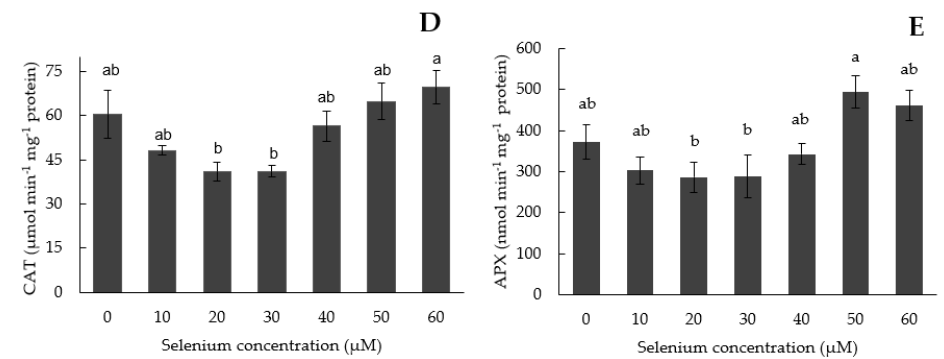
Figure 3. Effect of selenium concentration on lipid peroxidation (MDA) in rocket leaves ( A ). Effect of selenium concentration on the hydrogen peroxide content (H 2 O 2 ) in rocket leaves ( B ). Effect of selenium concentration on superoxide dismutase (SOD) in rocket leaves ( C ). Effect of selenium concentration on catalase (CAT) in rocket leaves ( D ). Effect of selenium concentration on ascorbate peroxidase (APX) in rocket leaves ( E ). The values represent the means of each treatment ( n = 3). Means followed by the same lowercase letter do not differ by Tukey’s test ( p > 0.05). Vertical bars designate standard error (± EP).